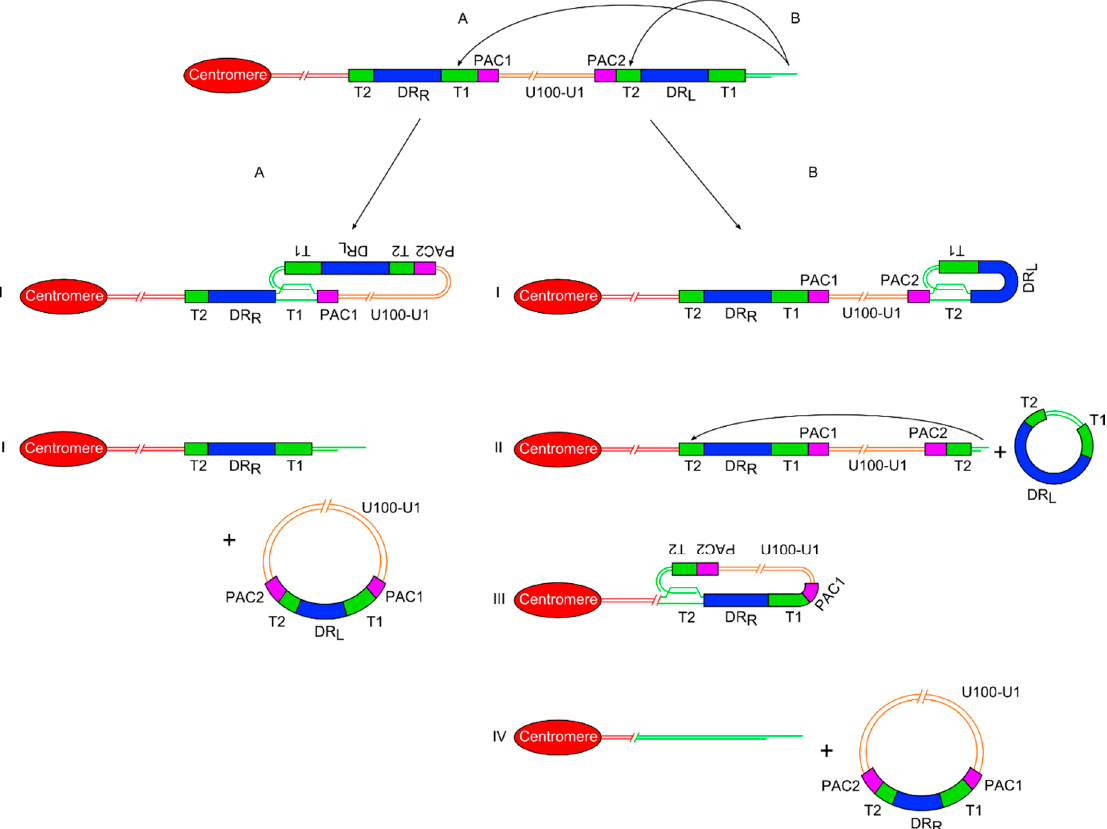
Figure 2. Diagram showing two proposed models of release of a ciHHV-6 genome from the telomere via t-loop processing mechanisms. ( A ) On the left side is the single t-loop model. (I) A t-loop forms between DR L -T1 and DR R -T1. (II) This t-loop facilitates release of the HHV-6 genome as a circular double stranded DNA molecule including the unique region and a recombinant DR, with restored PAC1 and PAC2 sequences. It also shows that a single DR lacking PAC sequences is retained in the telomere. ( B ) On the right side is the double t-loop model that releases the ciHHV-6 genome in two steps. (I-II) First with release of a circular DR region lacking PAC1 and 2 after t-loop formation between DR L -T1 and DR L -T2. (III-IV) This is followed by formation of a second t-loop between DR L -T2 and DR R -T2 which leads to the release of the HHV-6 genome including the unique region and a recombinant DR. In this double t-loop model, no residual DR sequences are left in the